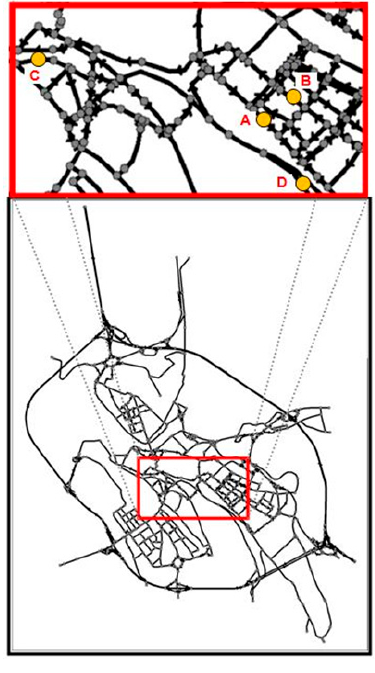
Figure 1. Survey locations.